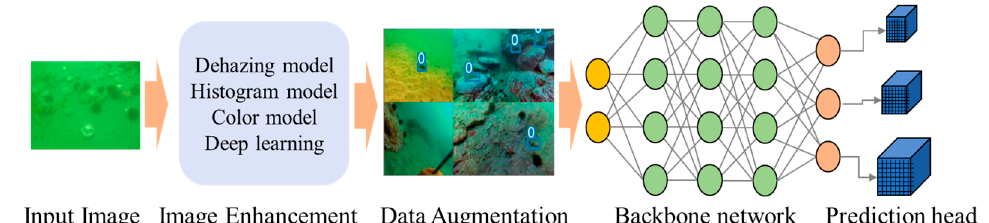
Figure 3. The overall structure of the proposed underwater sea cucumber detection